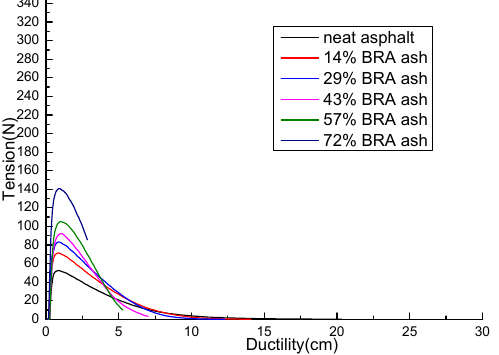
Figure 4. Comparison between tensile force and ductility of asphalt mortar with different BRA ash content. Table 12. Force ductility test result of BRA ash asphalt mortar.